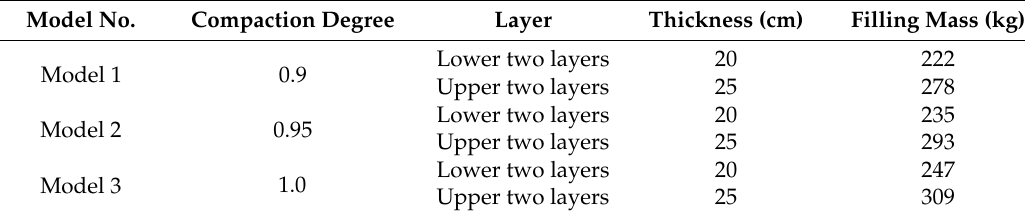
Table 1. Compaction degree for each model and filling mass for each layer. 190